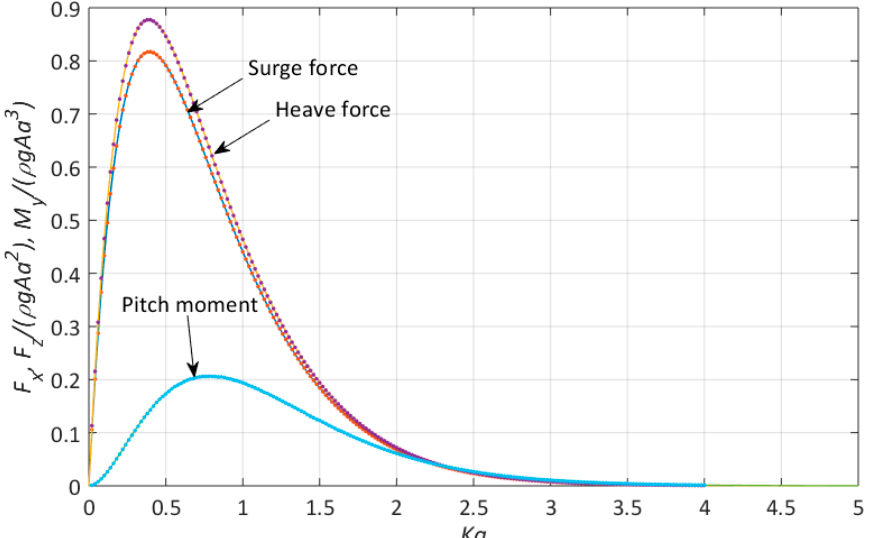
Figure 3. Magnitudes of the hydrodynamic loading acting on an oblate spheroid b / a = 0.8 immersed at f / a = 1 and subjected to regular wave action. The symbols denote the results obtained using WAMIT [14].